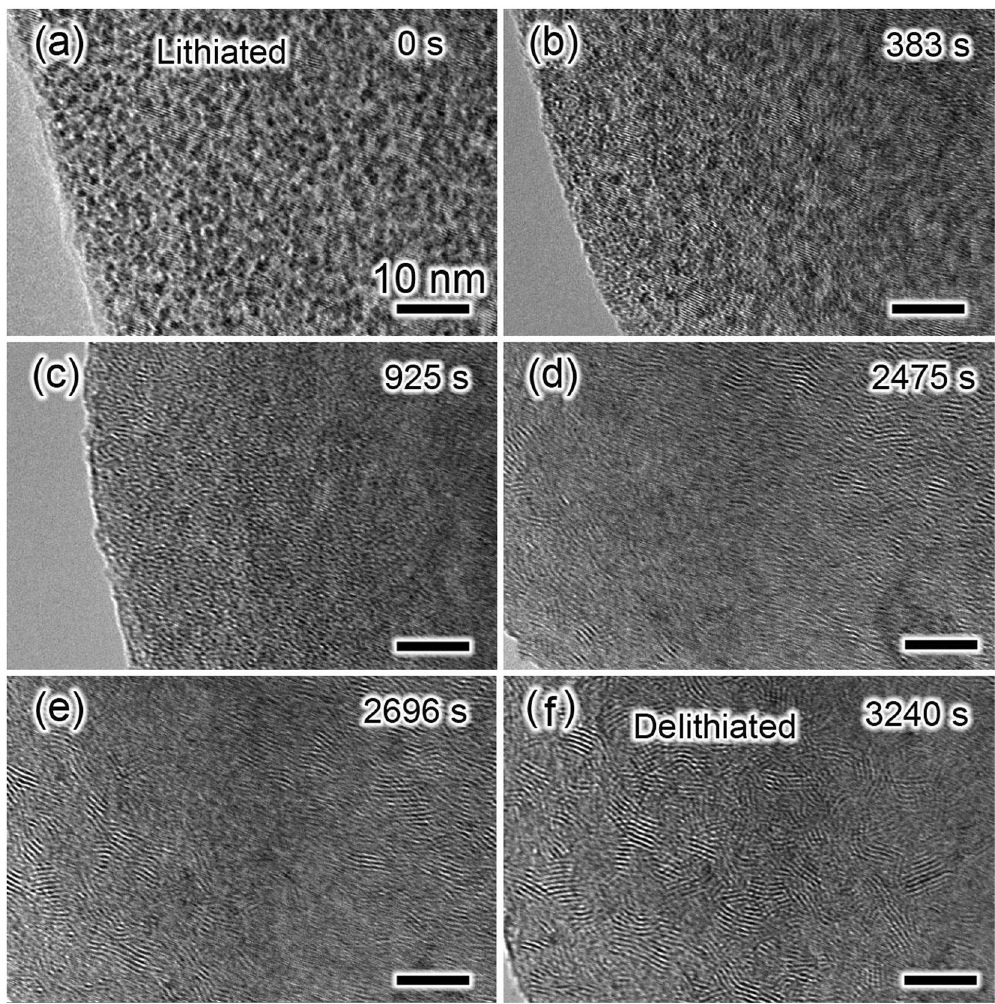
Figure 4. Time-resolved TEM images of a lithiated MoS 2 nanosheet during the delithiation process showing obvious microstructure and phase evolution as a function of time. ( a ) 0 s, ( b ) 383 s, ( c ) 925 s, ( d ) 2475 s, ( e ) 2696 s and ( f ) 3240 s. All the scale bars are 10